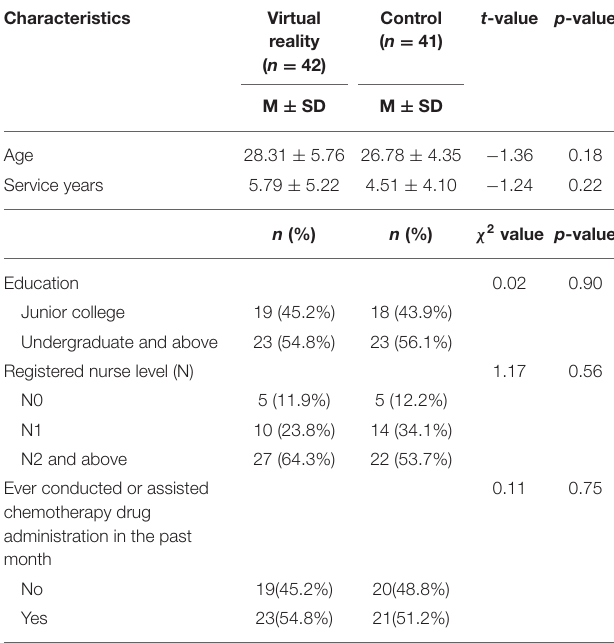
TABLE 1 | General characteristics of the study participants ( N = 83).